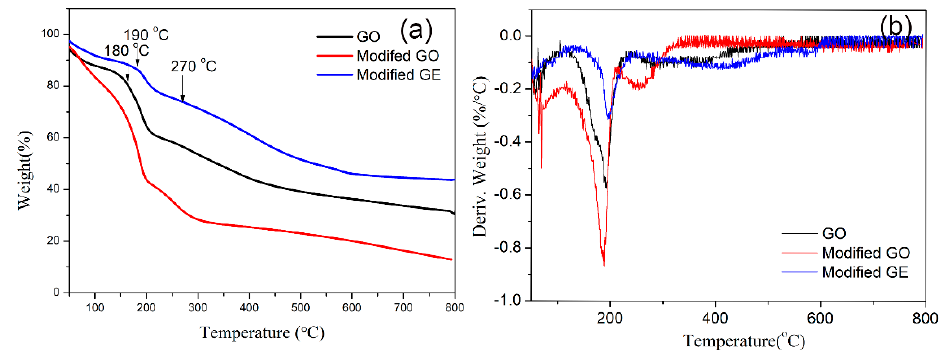
Figure 4. ( a ) TG of GO, modified GO, and modified GE; ( b ) DTG of GO, modified GO, and modified GE.